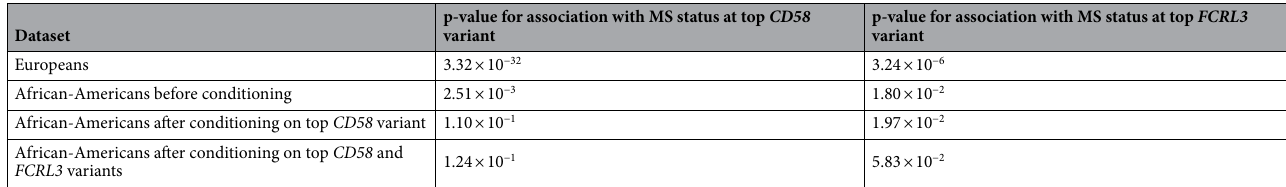
Table 2. p-values for association with MS status in different datasets. European dataset is the MS Chip association signal 15 . African-American dataset is the 2007 subset of the new cohort. The CD58 variant